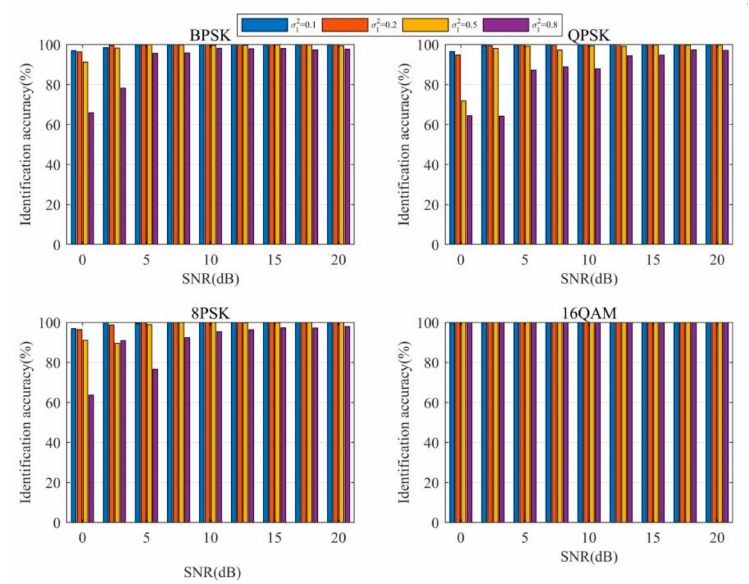
Figure 9. Histogram of the classification accuracies of four modulation schemes against the SNR under different turbulence